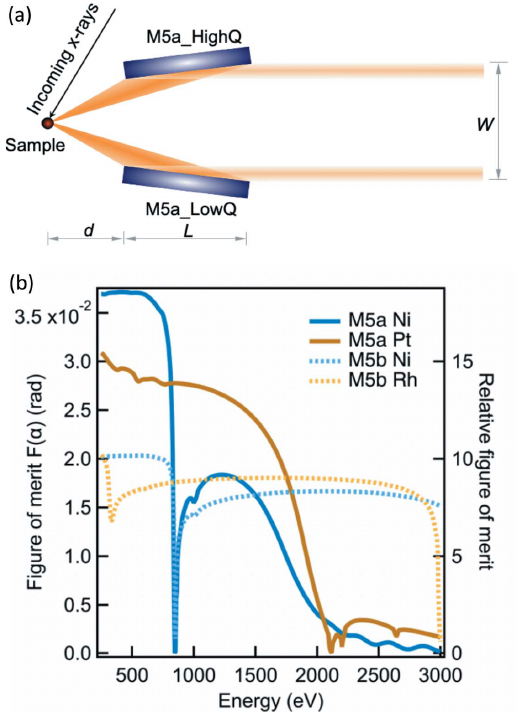
Figure 9 ( a ) Schematic top view of the M5a optics layout. d , L and W are equal to 55 mm, 190 mm and 30 mm, respectively, as optimized for the I21 beamline. ( b ) The simulated figure of merit of both M5a and M5b mirrors as a function of energy. The inset shows the zoom into the low-energy excitations of the